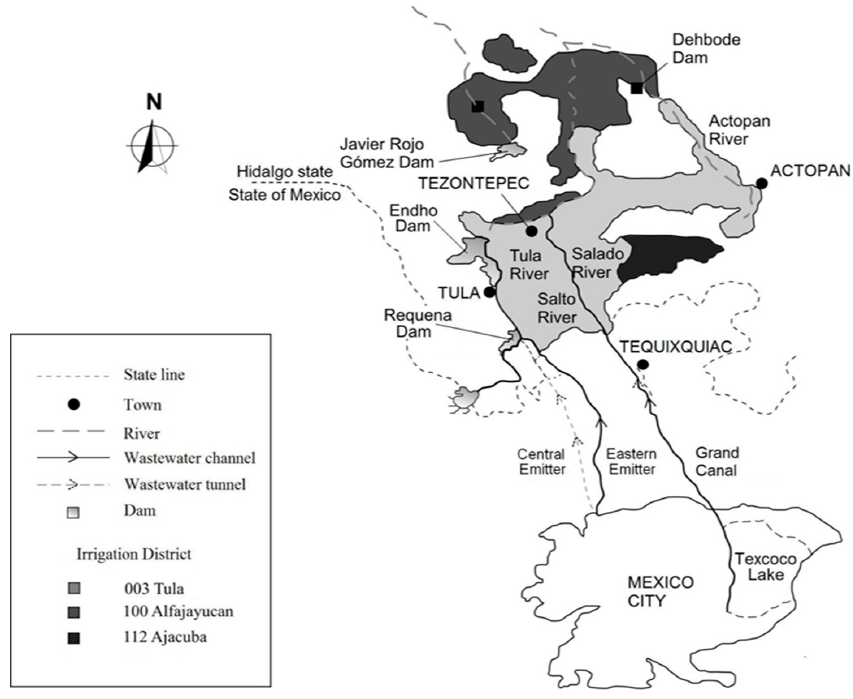
Figure 1. Transportation of wastewater generated in the Mexico Valley and sent to the Tula Valley (Source: “Grupo Tratamiento y Reúso del Agua”).